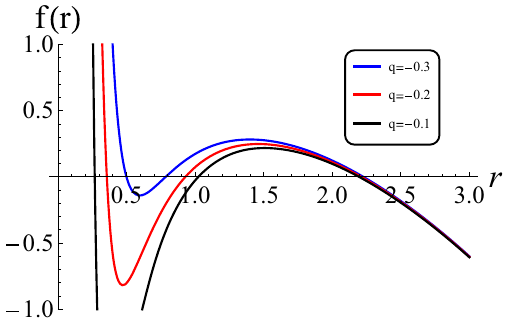
Fig. 3 The same as Fig. 1, but with different value of q (the other parameters are fixed at Λ = 1, k = 1, e = 0 . 2, and m =